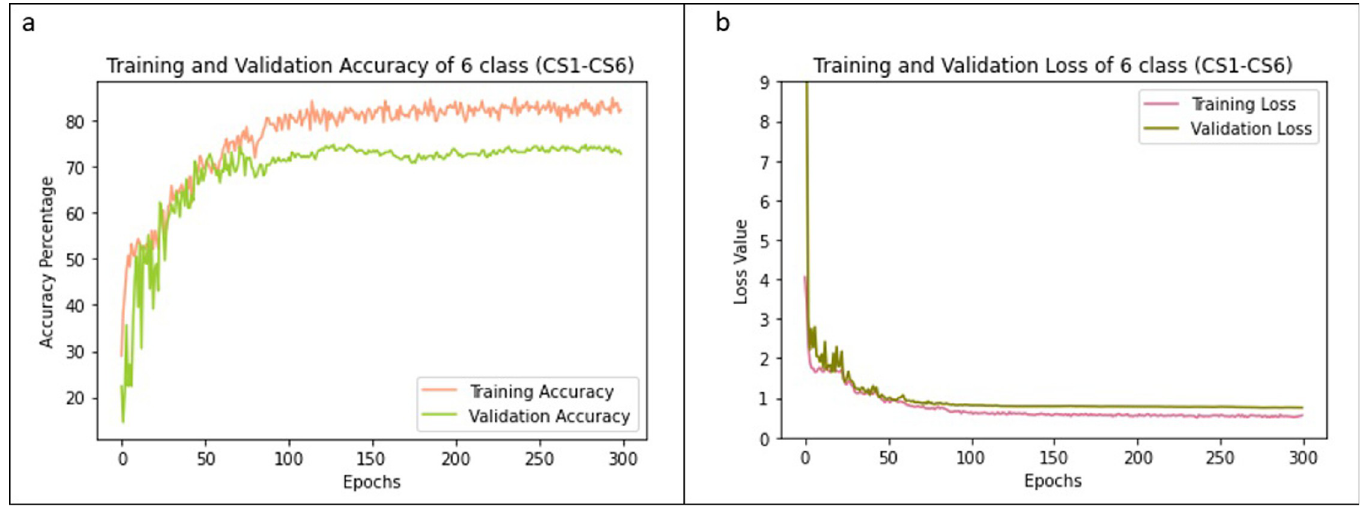
Fig 5. Training and validation accuracy and losses for 6-stage classification. The accuracies (a) and losses (b) of CNN model with the directional filters obtained by averaging 5 folds are shown.